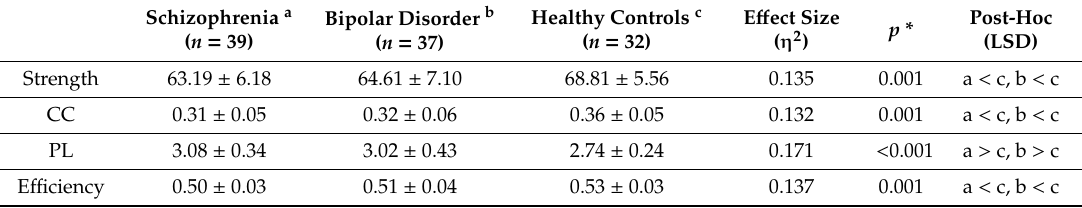
Table 2. Mean and standard deviation values of global network indices, including strength, clustering coe ffi cient (CC), path length (PL) and e ffi ciency, for the schizophrenia, bipolar disorder and healthy control